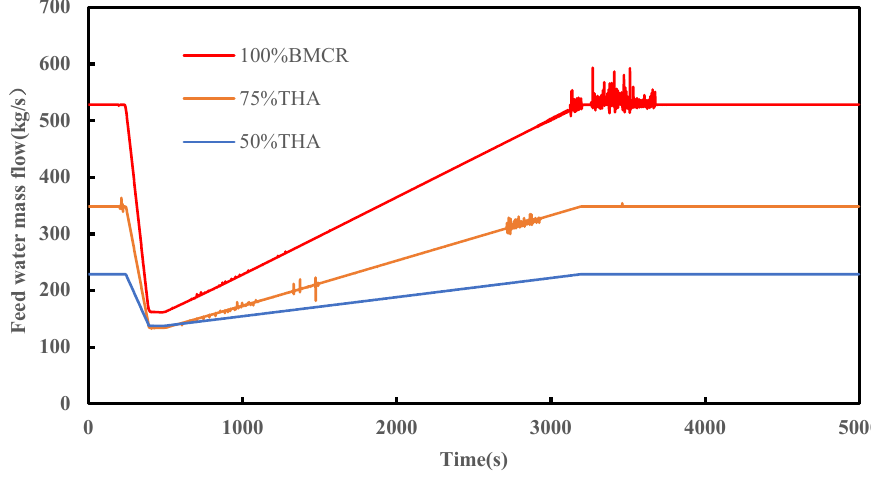
Figure 10. Response of feed water mass flow during MFT at different conditions. From the results under 100% BMCR, 75% THA, and 50% THA conditions, it can be seen that after triggering MFT under 50% THA condition, the steam moisture separator